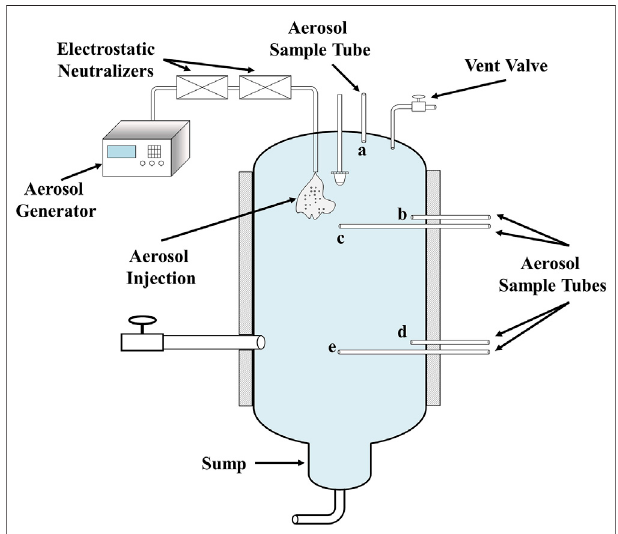
FIGURE 2 | Overview of the COSTTHES facility.